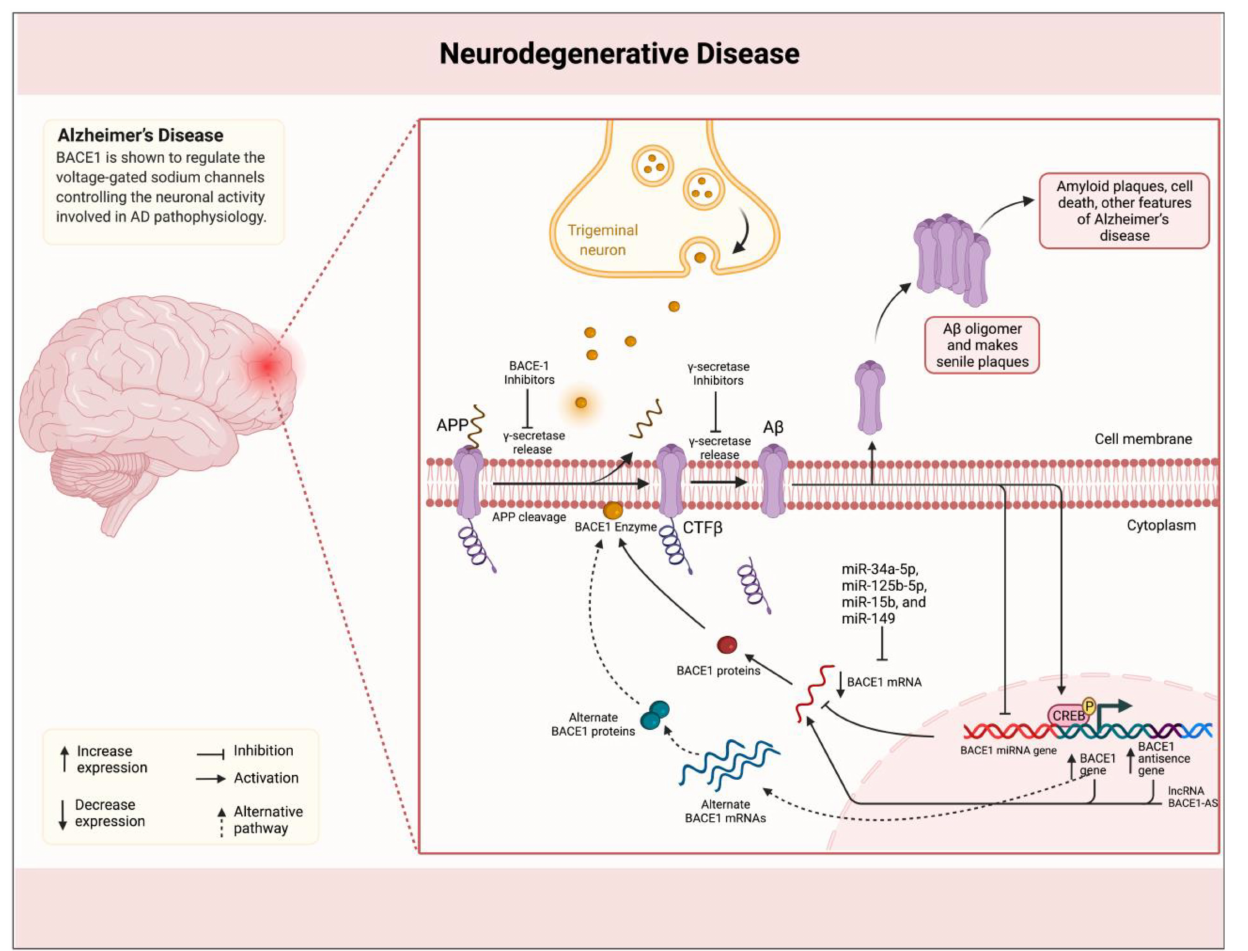
FIGURE 1 | BACE1-AS promotes the synthesis of β -secretase in the brain of patients with AD. Amyloid plaques in the brain of patients with AD are linked to the illness. Plaques are formed by the successive breakdown of the APP via β -secretase (BACE1) and γ -secretase. In individuals with BACE1 deficiency, the mRNA is stabilized by binding to its antisense non-coding RNA (BACE1-AS). miRNAs, such as miR-34a-5p, miR-125b-5p, miR-15b, and miR-149, inhibit BACE1 expression, decrease amyloid accumulation, and ameliorate neuronal